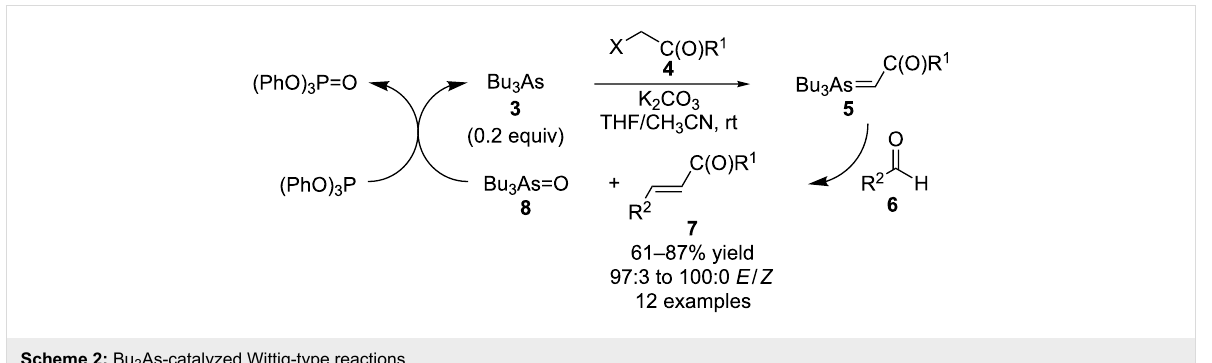
Scheme 2: Bu 3 As-catalyzed Wittig-type